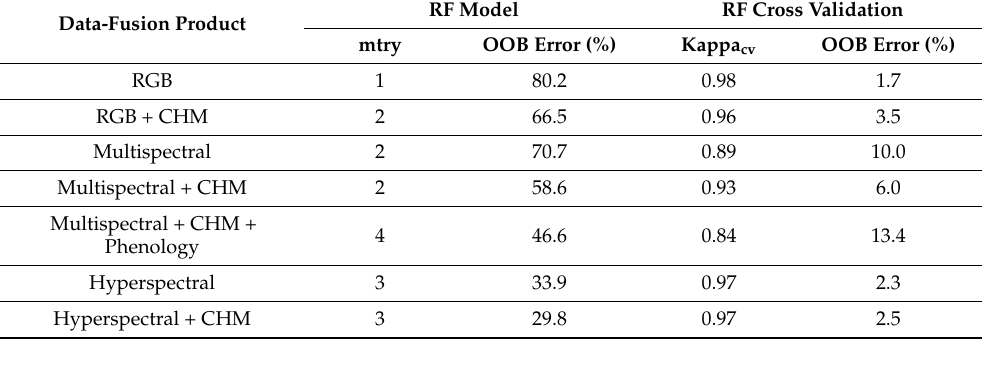
Table 4. Random forest (RF) model parameters and cross-validation statistics for each data-fusion product. The number of random variables ( mtry ), OOB error, and Kappa cv are described for each product. Tree number was constant at 500 for all RF analyses. See text for descriptions of OOB error and Kappa cv . Data-Fusion Product